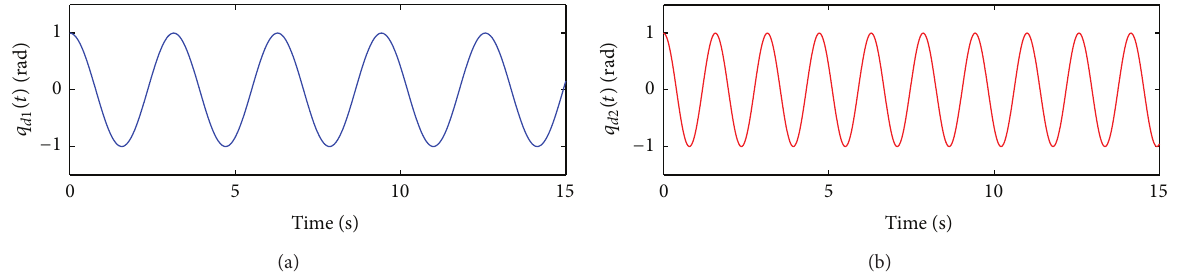
Figure 2: Desired joint trajectories 𝑞 𝑑1 (𝑡) and 𝑞 𝑑2 (𝑡) used in the real-time